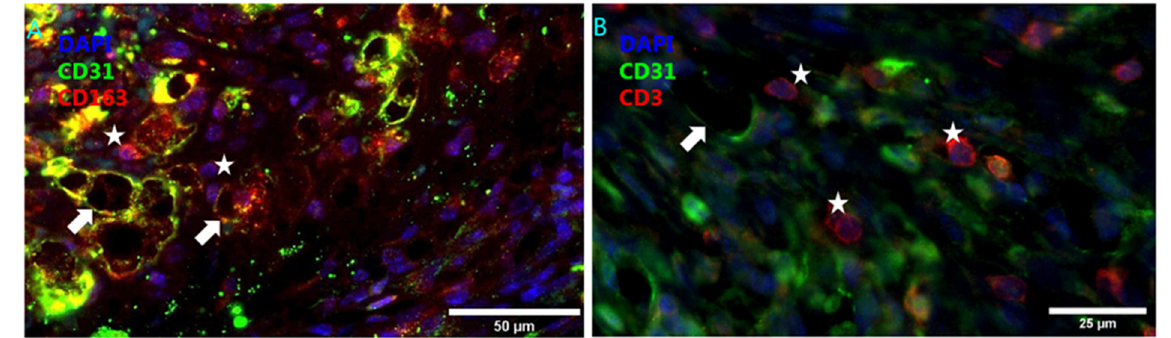
Figure 4. Inflammatory cell association with plaque neovessels. Inflammatory cells (indicated by stars) located near neovessels (indicated by arrows) in murine atherosclerotic vein grafts ( A ) Hemoglobin associated CD163+ macrophages localizing near neovessels, DAPI (blue), CD31 (green), and CD163 (red) ( B ) CD3+ T cells localizing near neovessels, DAPI (blue), CD31 (green) and CD3 (red).